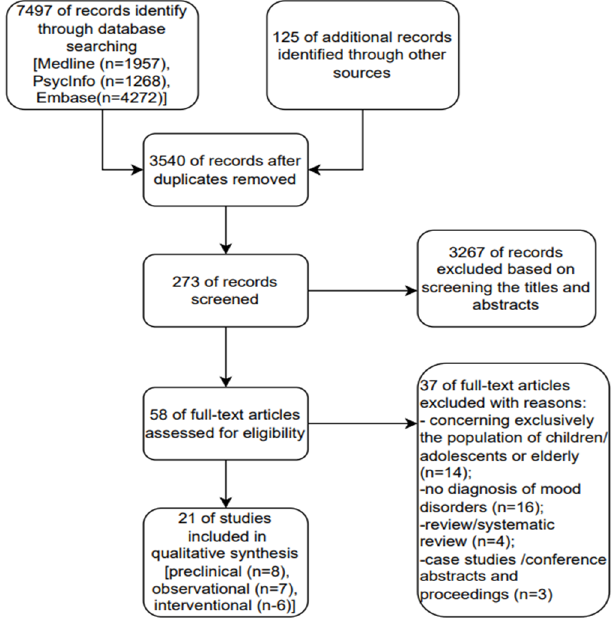
Figure 1. Flow chart: an overview of the study selection process.